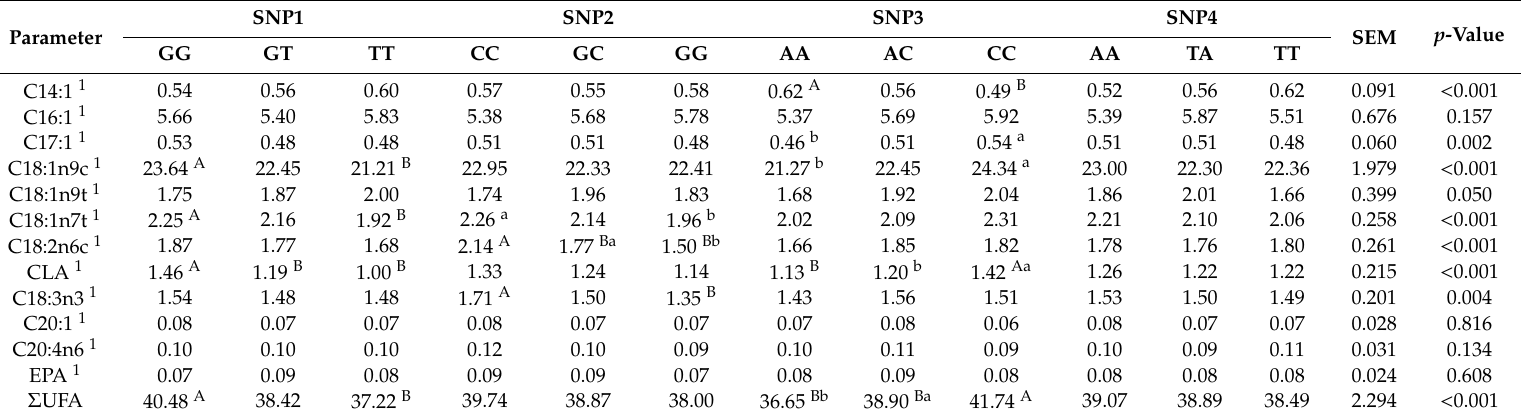
Table 6. Unsaturated fatty acids content in milk from Zošl’achten á valaška sheep in relation to particular genotypes of SLC27A3 gene